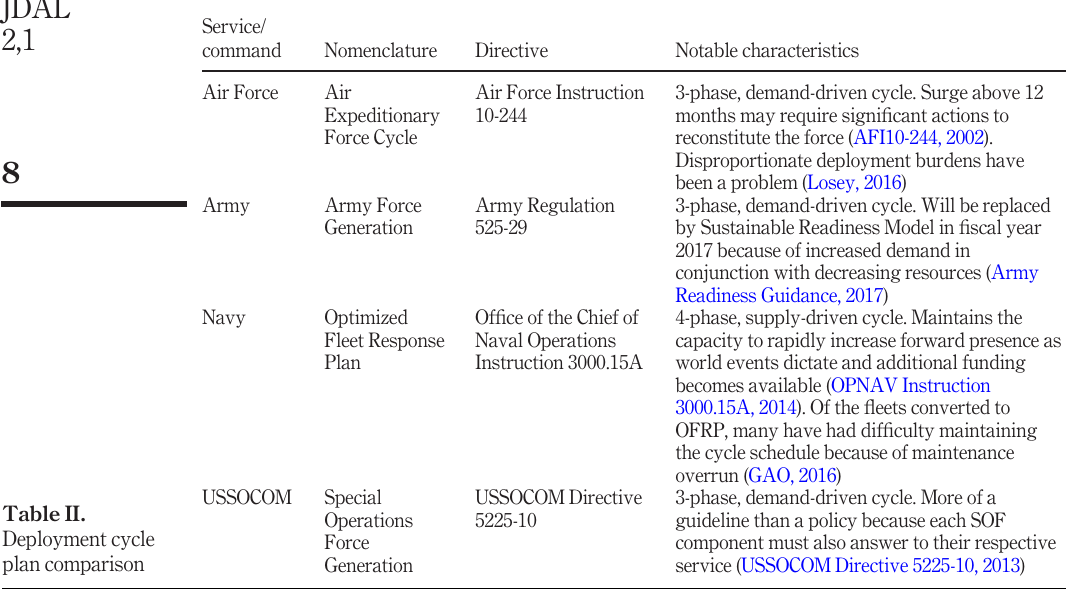
Table II. Deployment cycle plan